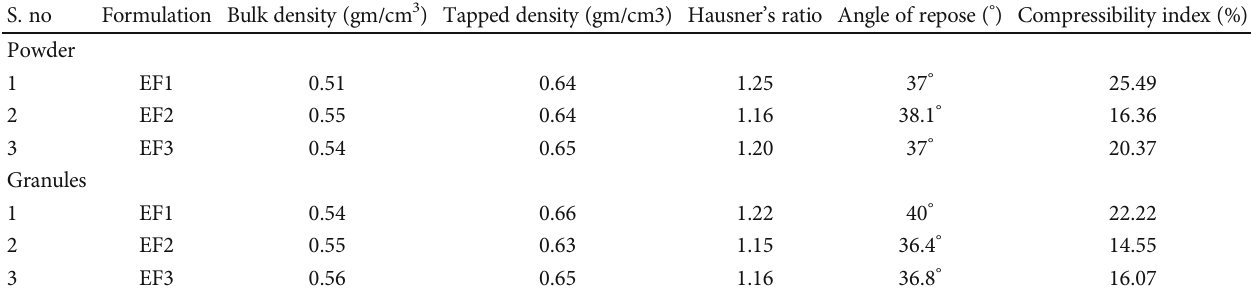
Table 2: Evaluation of precompression parameters of formulation EF1-EF3.